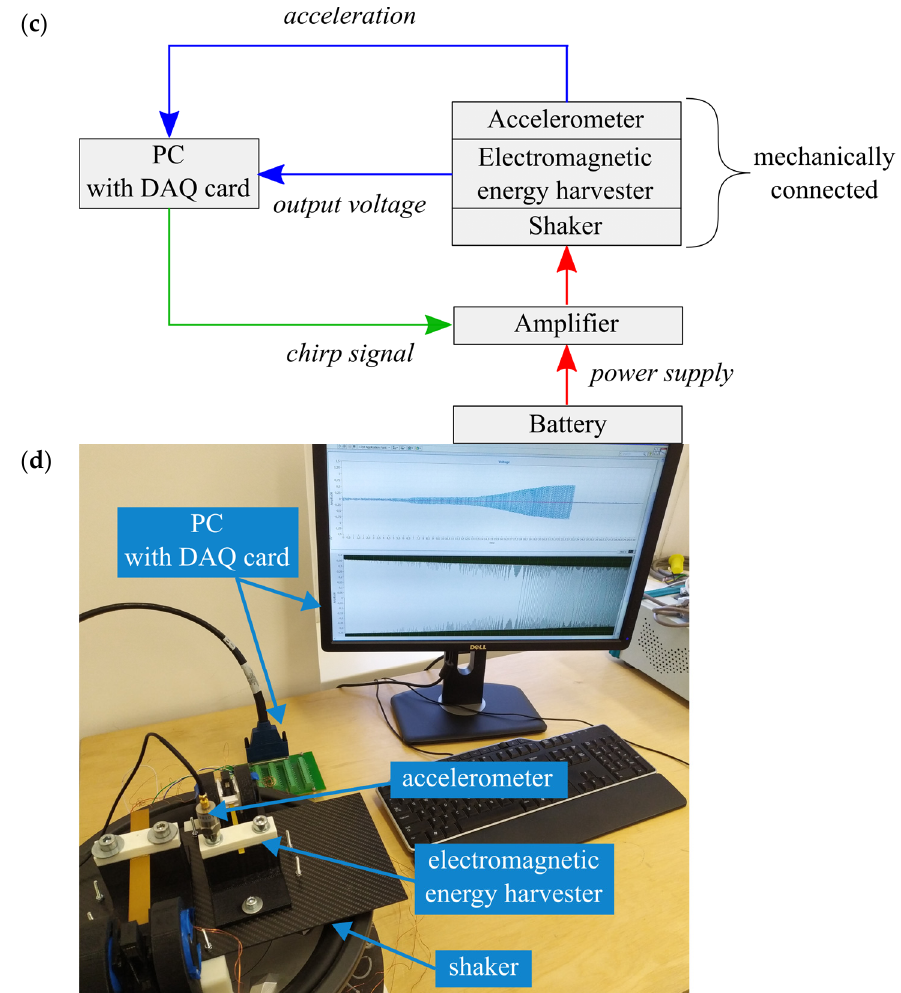
Figure 2. ( a ) CAD diagram of nonlinear system vibration energy harvester using electromagnetic mini-generator; ( b ) physical model on laboratory test-stand; ( c ) schematic diagram of a test-stand and ( d ) photograph of a test-stand.